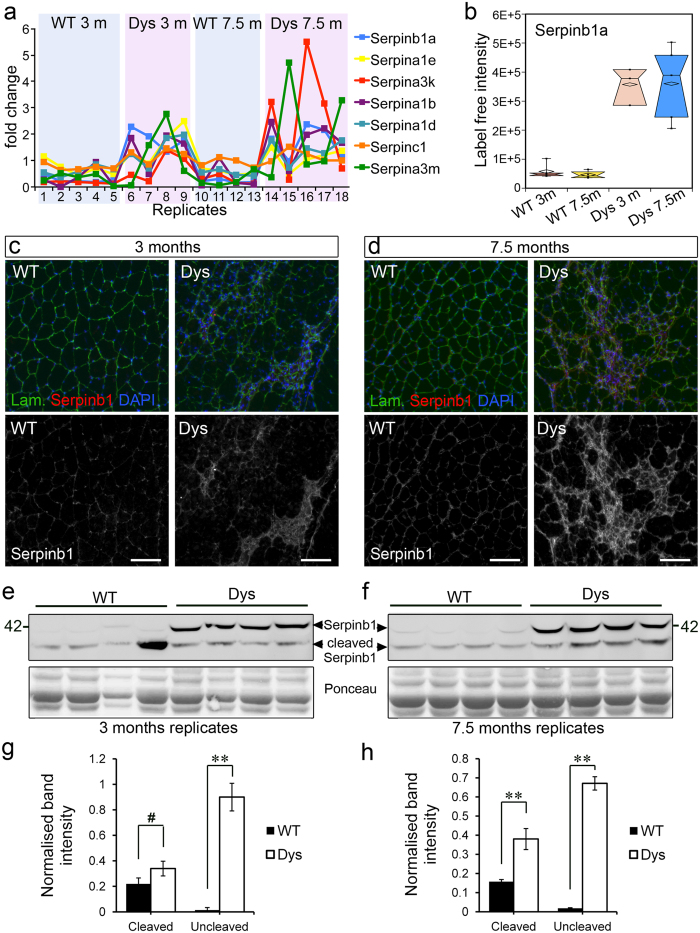
The leukocyte elastase inhibitor (Serpinb1a) is increased in dystrophic muscle from both age groups.(a) Seven different serine protease inhibitors (Serpins) were identified by mass spectrometry as differentially abundant in wild type and dystrophic muscle from both age groups. Five of these seven Serpins progressively accumulated with disease progression (greater increase in dystrophic over wild type muscle at 7.5 months than at 3 months of age) while two showed the opposite trend: greater increase in dystrophic over wild type muscle at 3 months than at 7.5 months of age. The most significantly different Serpin is the leukocyte elastase inhibitor Serpinb1a. (b) Serpinb1a is increased in dystrophic muscle at 3 and 7.5 months of age compared to age-matched wild type controls. Box plots were informed by LC-MS/MS quantification of Serpinb1a. (c,d) Gastrocnemius muscles of wild type (WT) and dystrophic (Dys, mdx4cv) mice were dissected at the indicated ages, cryosectioned and immunostained as indicated. (e,f) Western blot analysis of wild type and dystrophic (mdx4cv) muscle confirms increased amounts of Serpinb1a in dystrophic versus wild type muscles. (g) Quantification of (e) where the outlier wild type (lane 4) was ignored. We believe this outlier could be the consequence of an accidental muscle injury. (h) Quantification of (f). **p < 0.01; #p > 0.05. Scale bars are 100 μm in (c,d).